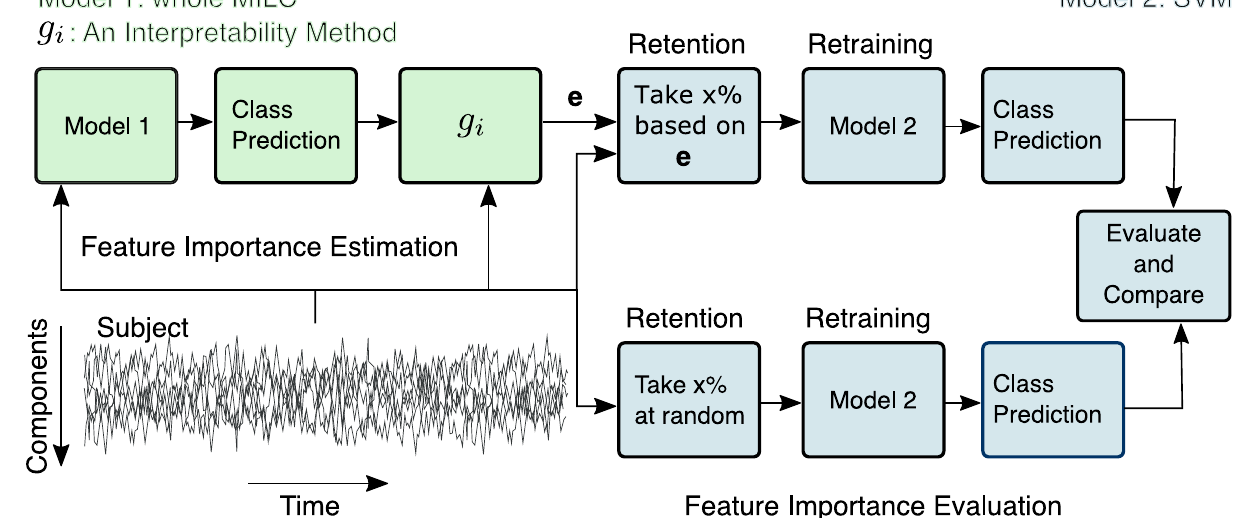
R using the RAR method R ), where ξ is the performance